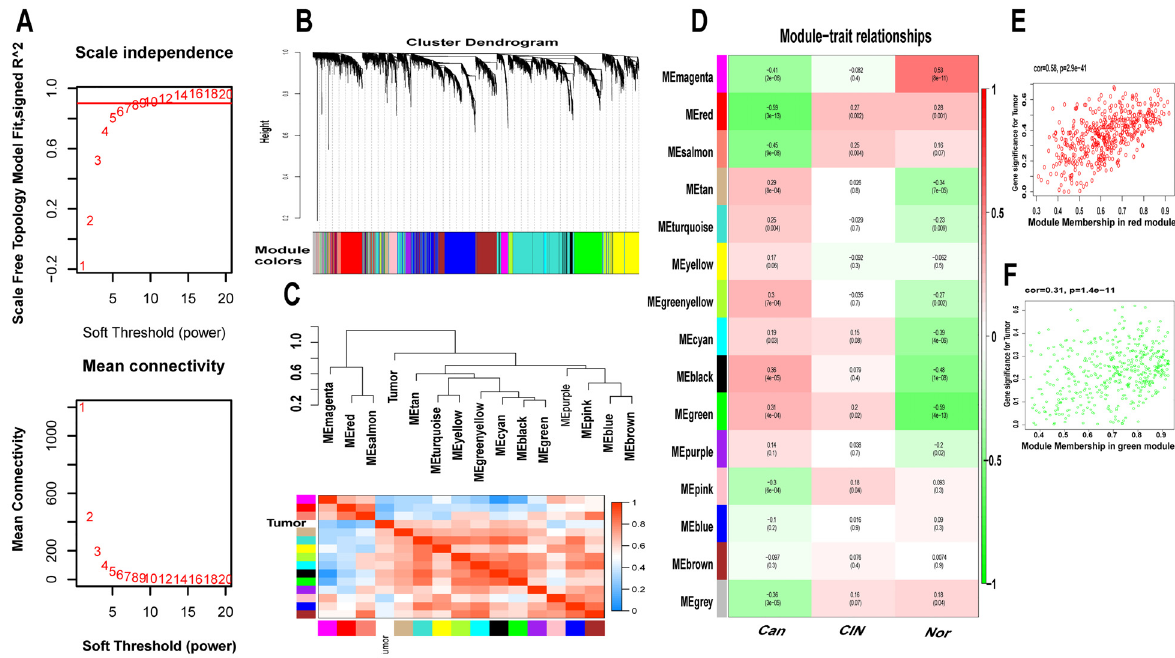
Figure 2. Identi fi cation of signi fi cant gene modules. A , A scale-free network was constructed in the GSE63514 database with the soft-thresholding power set at 7. B , Clustering dendrograms of genes based on dissimilarity topological overlap and module colors in the GSE63514 database are shown. C , A dendrogram is shown of consensus module eigengenes obtained by weighted coexpression network analysis on the consensus correlation and heatmap plot of the adjacencies of modules in the GSE63514 database. D , Scatter plots of gene signi fi cance relative to module membership in the GSE63514 database are shown. E and F , Scatter plots of red and green modules in the GSE63514 database are represented.